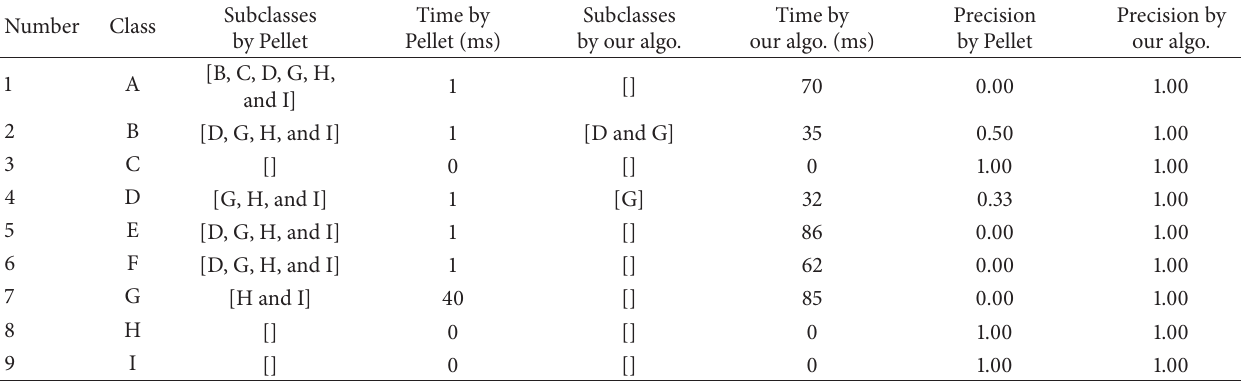
Figure 3: Cases of adding union and intersection classes. Table 3: Calculating list of sub classes: